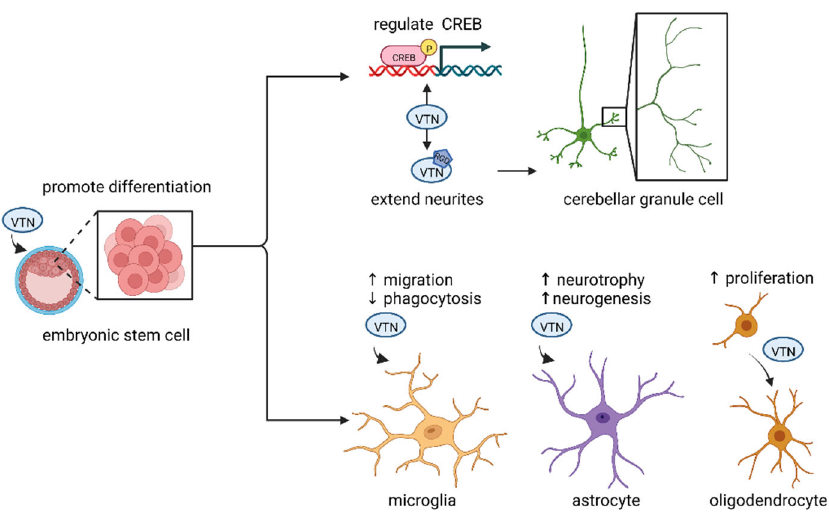
Figure 2. Schematic representation of VTN functions in different cells of the nervous system. The differentiation of embryonic stem cells can be promoted by changing ECM and selecting VTN. Fur ‐ thermore, VTN acts on cerebellar granule cells by 2 ways: inducing CREB phosphorylation to regu ‐ late differentiation and utilizing RGD site to extend neurites, and it is also closely related to glial cells. VTN can promote microglia migration and inhibit phagocytosis. Moreover, it can induce neu ‐ rogenesis and neuroprotection of astrocytes and proliferation of dendritic cells. Created with Bio ‐ Render.com (accessed on 11 October 2022).